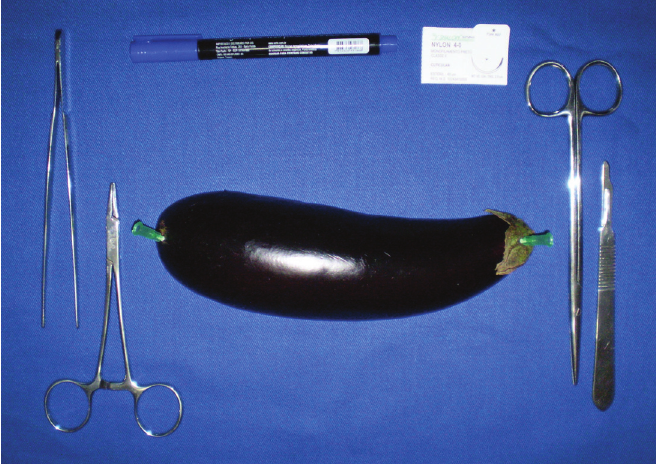
FIGURE 1 – Organic bench model and materials required for the teaching and learning on basic surgical